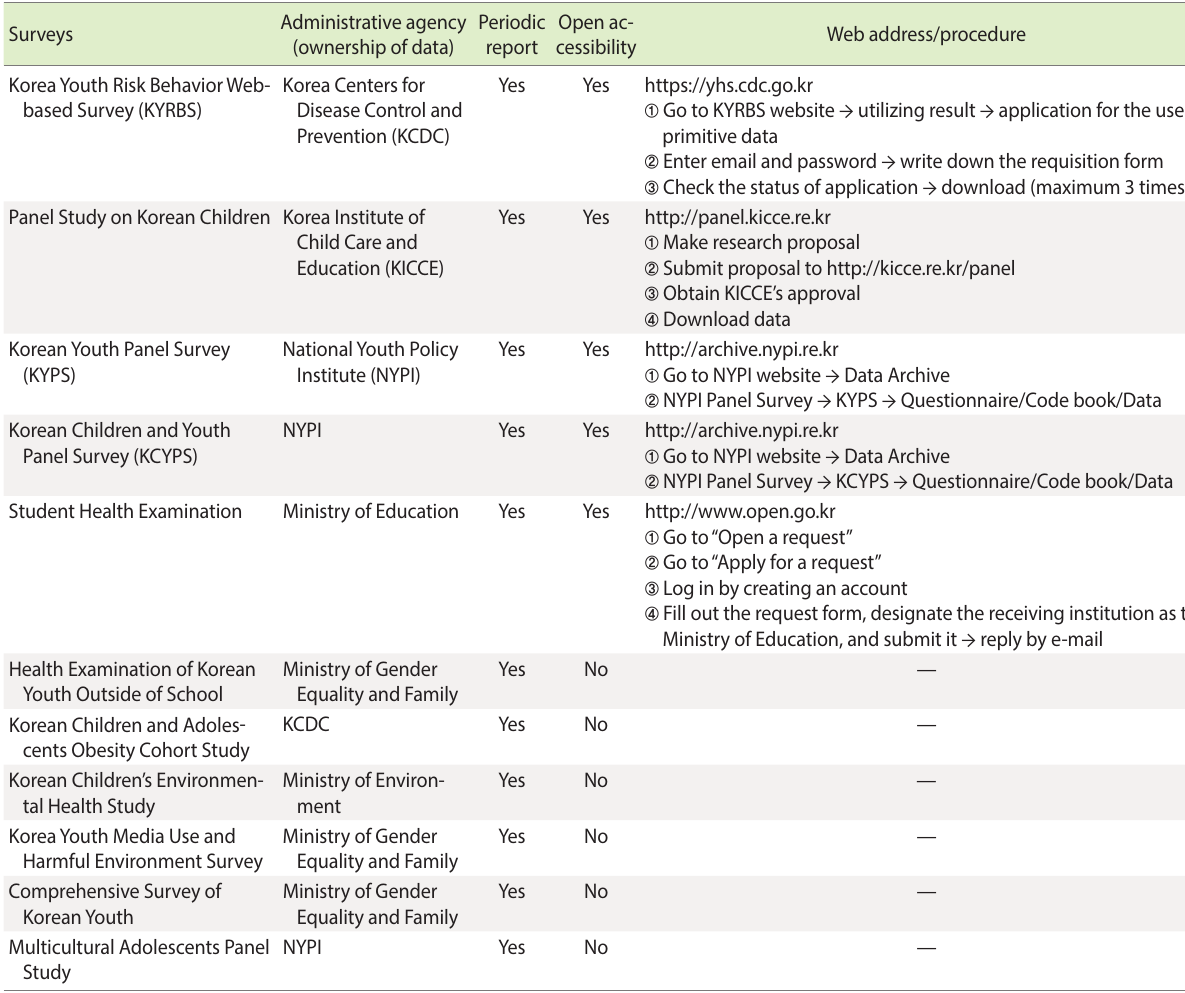
Table 3. Data accessibility